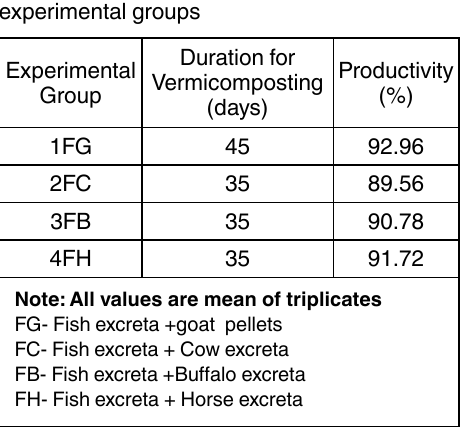
table 1. Time taken for completion of